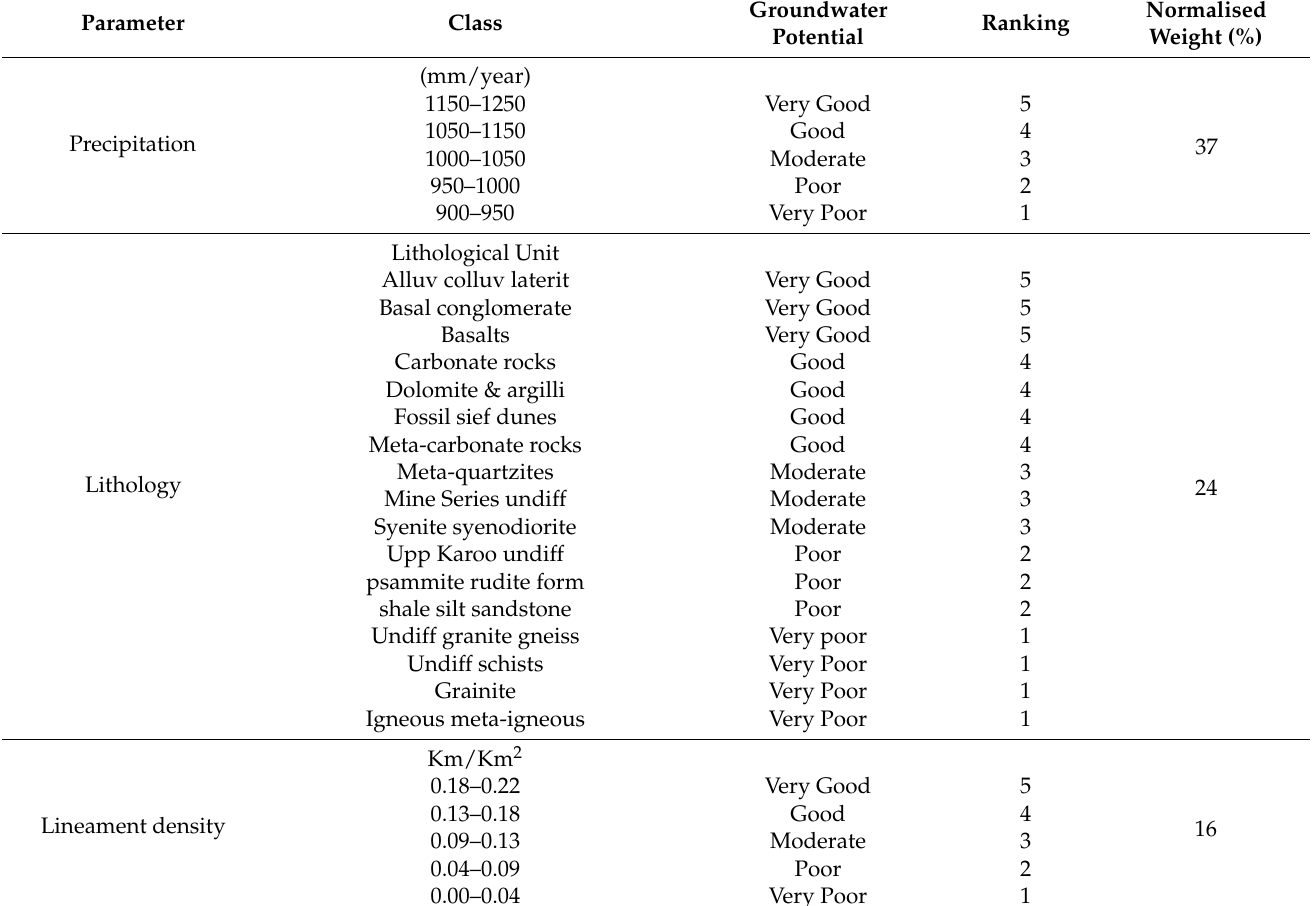
Table 3. Thematic layers with ranks and normalised